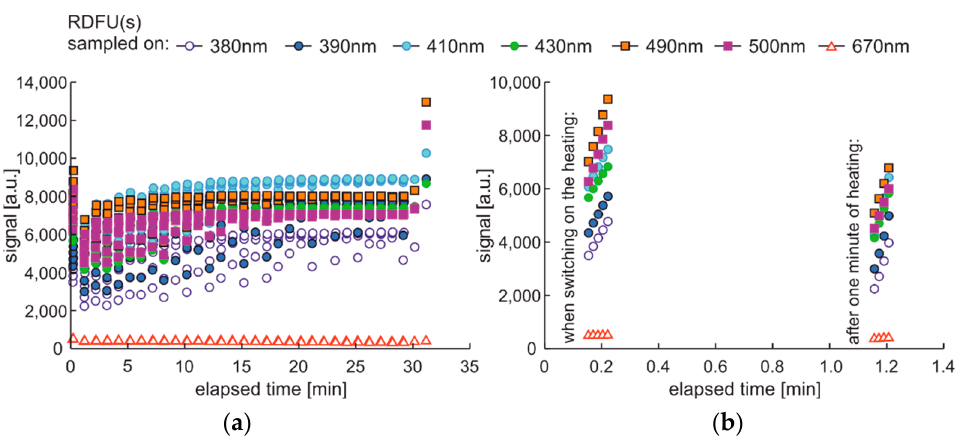
Figure 17. Set of time series of fluorescence data of regular diesel fuel RDFU(s) in cycle DCE:UVoffTon: ( a ) complete time series; ( b ) zoom of the initial stage.